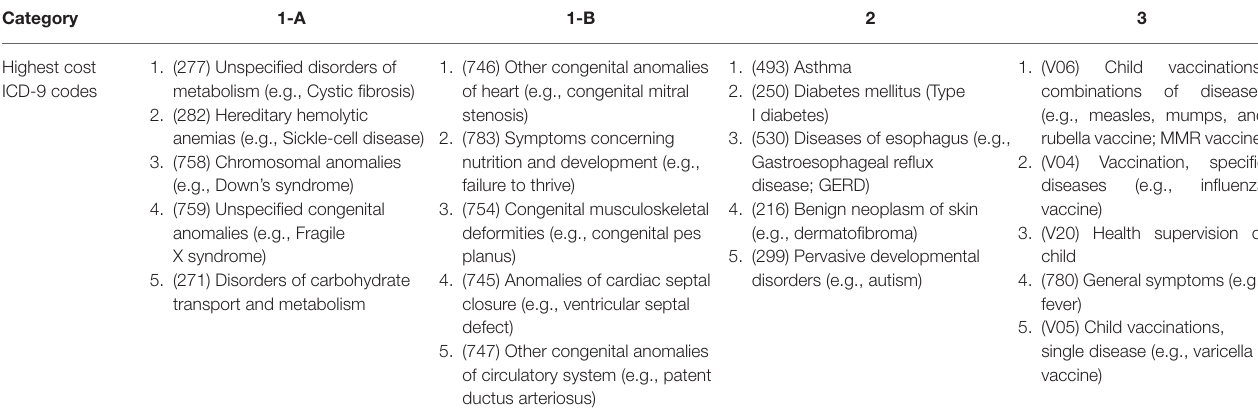
TABLE 5 | Highest annual costs * ICD-9 diagnoses.